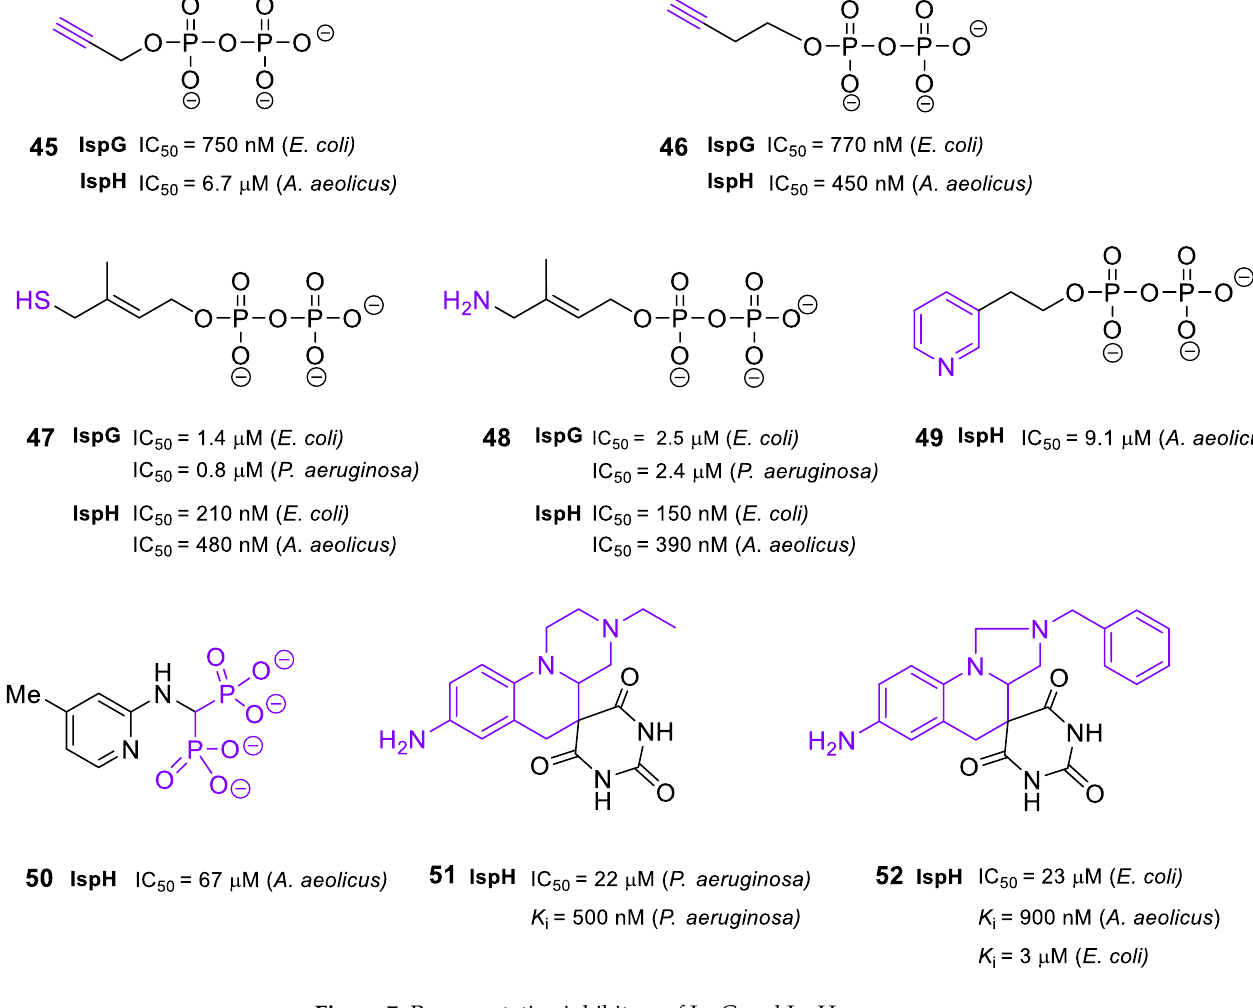
Figure 7. Representative inhibitors of IspG and IspH.